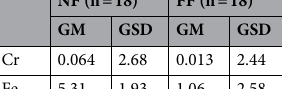
NF (n = 18) FF (n = 18) GM GSD GM